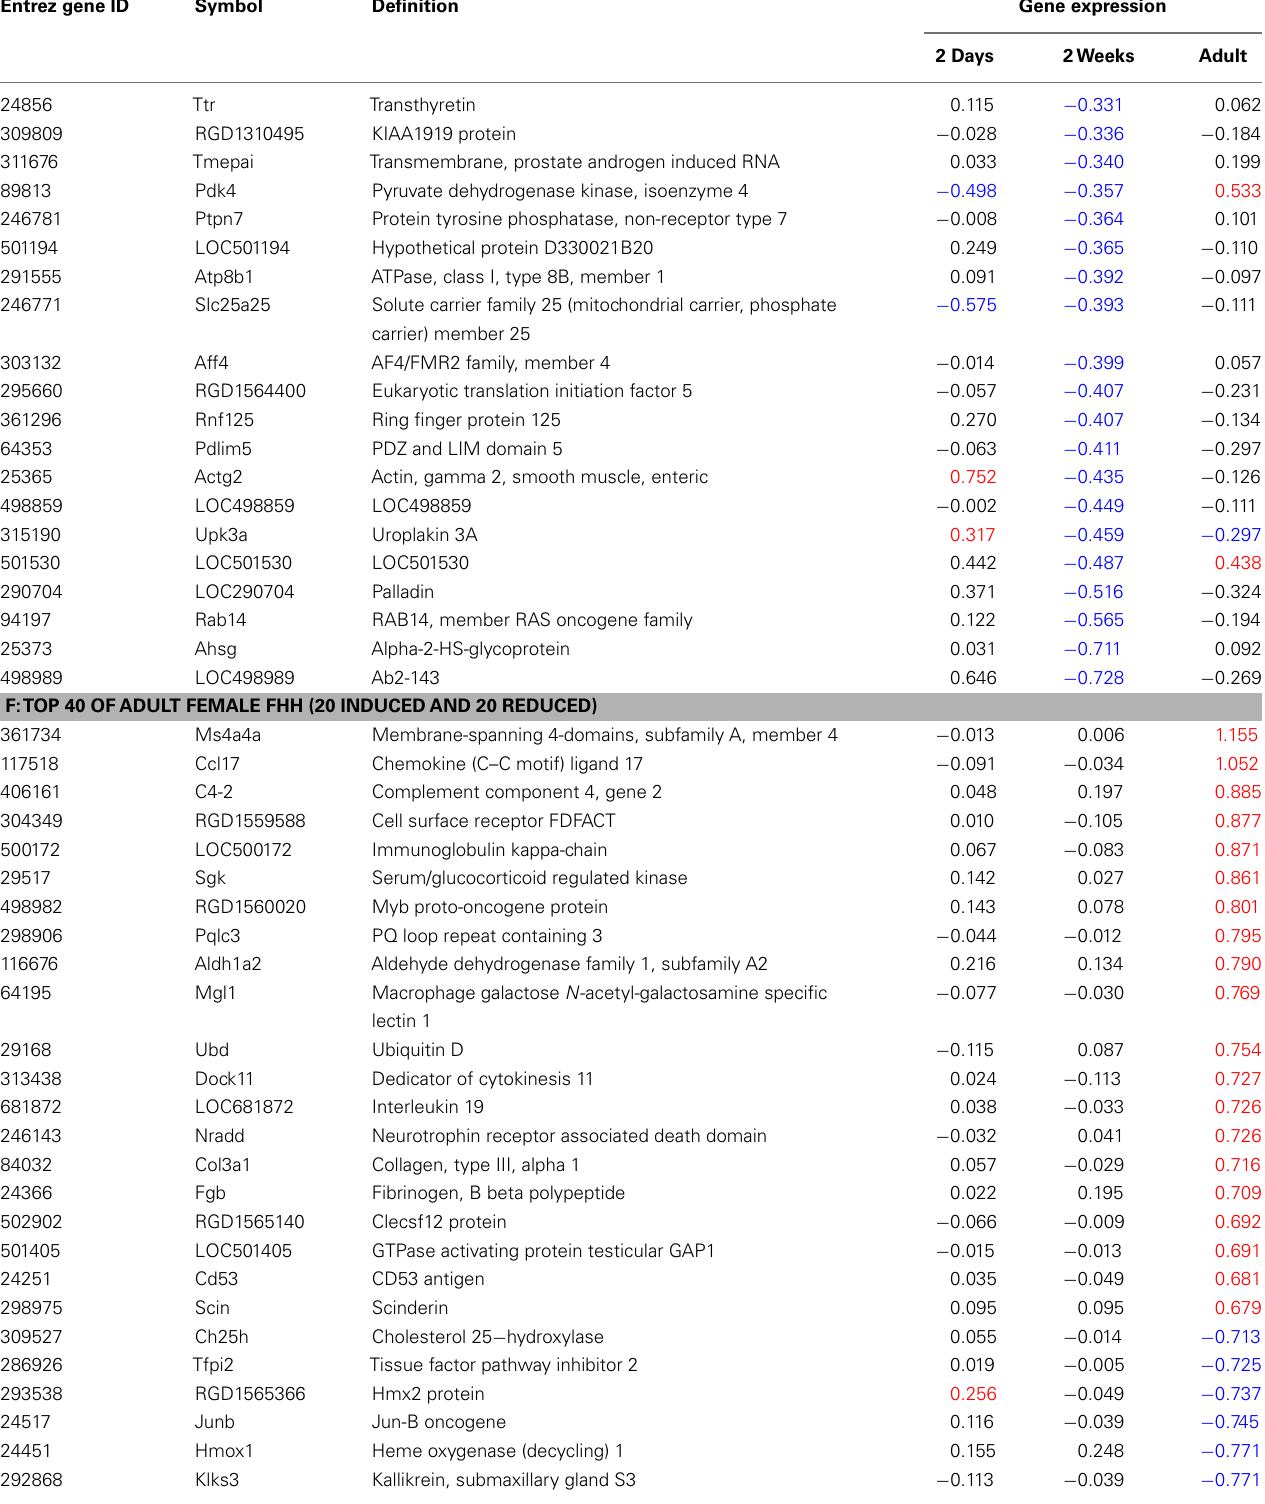
F:TOP 40 OFADULT FEMALE FHH (20 INDUCEDAND 20